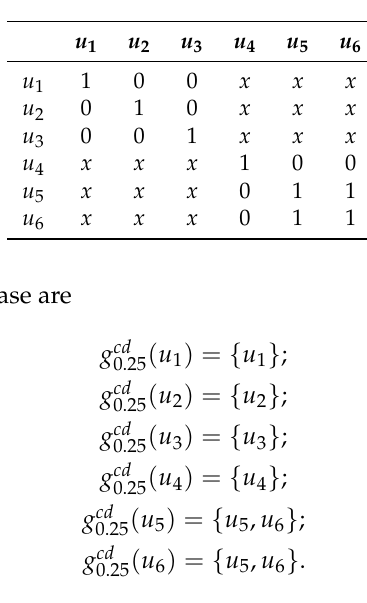
Table 2. gcdm (1 when u i is indiscernible by a degree r gran = 0.25 from u j , 0 otherwise , d ( u i ) is equal d ( u j ) .)